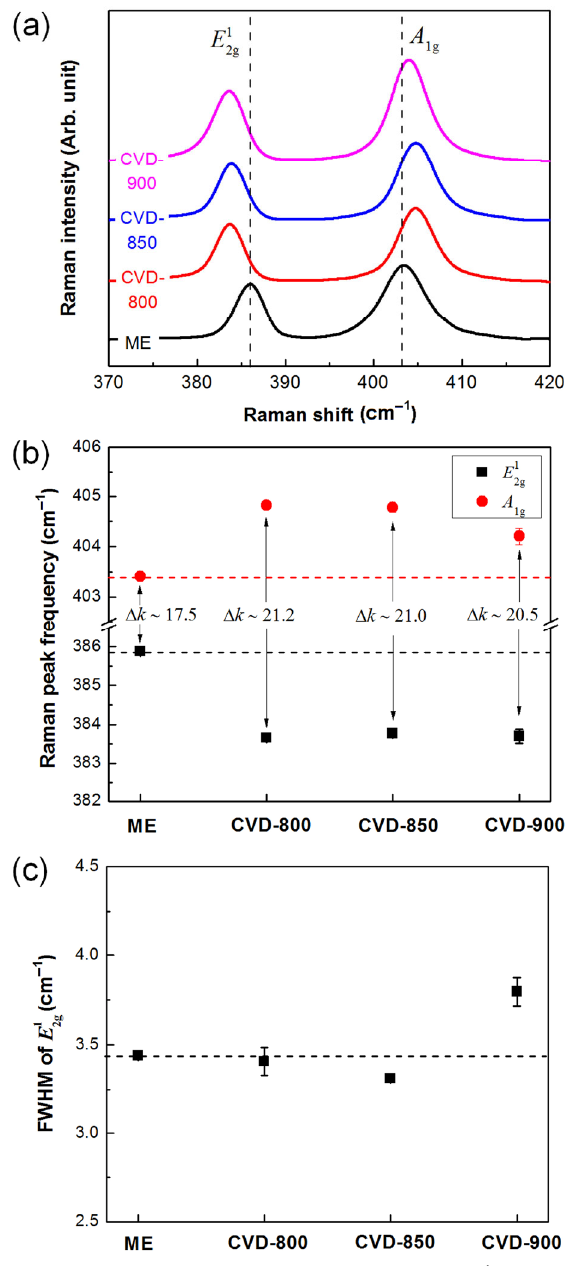
E and A Fig. 2 (a) Raman spectra, (b) frequencies of the 1 2g 1g peaks and the frequency separation, ∆ k , and (c) FWHM of the 1 E peak of the mechanically exfoliated single-layer MoS 2 and 2g CVD-grown single-layer MoS 2 at 800 ° C, 850 ° C, and 900 ° C. E and A peaks In (a), (b), and (c), the frequency of the 1 2g 1g E peak of the mechanically exfoliated and FWHM of the 1 2g single-layer MoS 2 are indicated with dashed lines for comparison. In (b) and (c), the error bar represents one standard deviation. MoS [47]. Additionally, the measured values of ∆ k 2 for the CVD-grown MoS at 800 ° C, 850 ° C, and 900 ° C 2 were 21.2 cm − 1 , 21.0 cm − 1 , and 20.5 cm − 1 ,